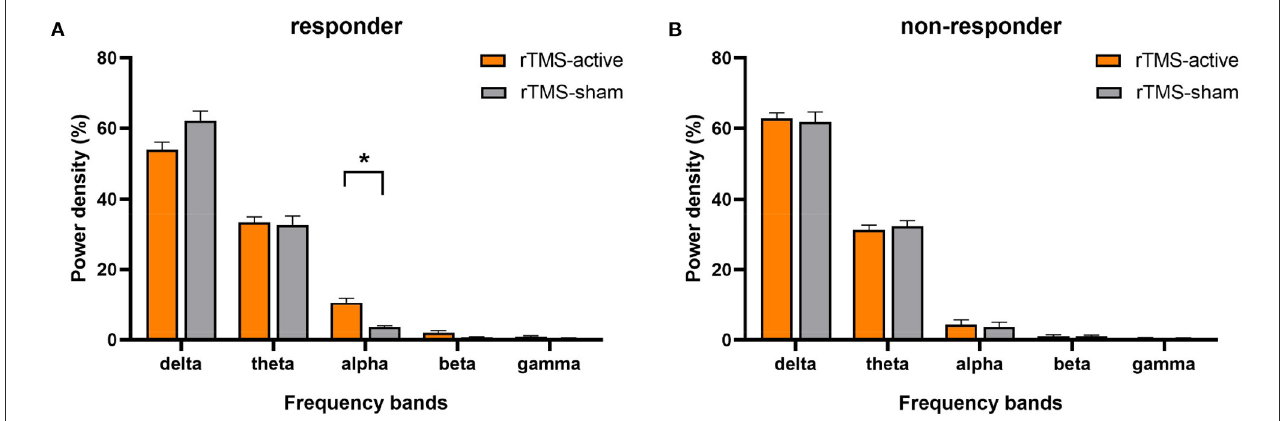
FIGURE4 The result of the general linear model ANOVA showed changes in EEG relative power in five frequency bands for responders and non-responders, respectively (rTMS-active and rTMS-sham). (A) Statistical significance in responders was found in the relative alpha power (* p < 0.01). The data were expressed as the means ± SEM. (B) No significant difference was found for non-responders in any